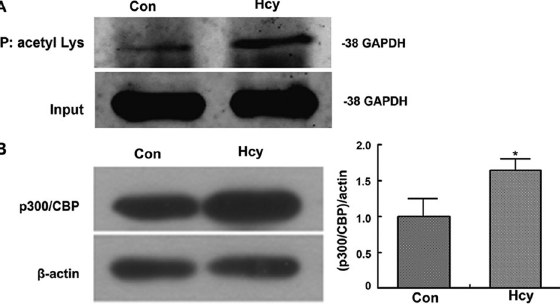
Figure 5. Glyceraldehyde 3-phosphate dehydrogenase (GAPDH) acetylation and expression level of p300/CBP protein. Neuro2a cells were incubated in the presence of 5 mM homocysteine (Hcy) or absence (control [con]) of Hcy for 48 h. A , Acetylated proteins in whole cell extracts were immunoprecipitated with acetylated lysine antibody. The GAPDH fractions were then detected by Western blotting. B , Protein levels of p300/CBP in whole cell extracts were detected by Western blotting. *P o 0.05 (Student-Newman-Keuls test).